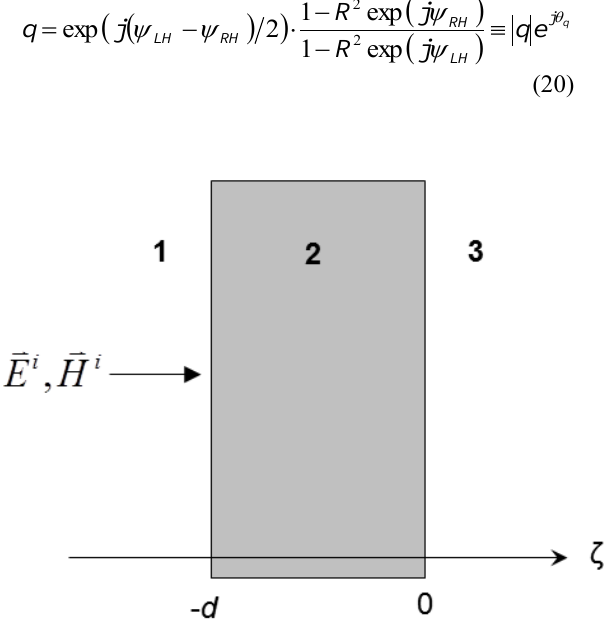
Figure 3: Pasteur Slab Sandwiched Between Two Isotropic Half-Spaces [1] The LHP and RHP propagation